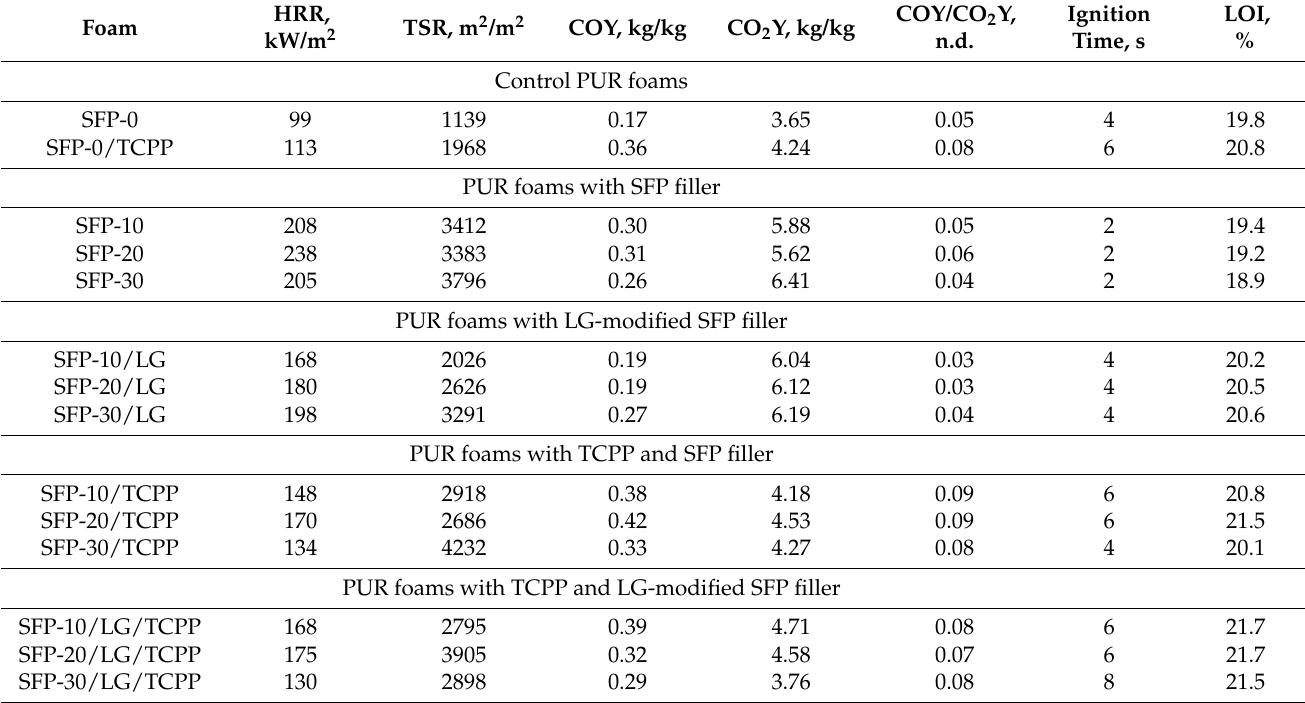
Table 5. Cone calorimeter test data of PUR and flame retardant PUR